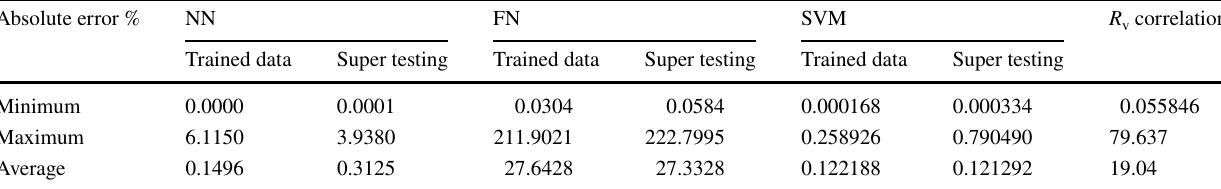
Table 4 Statistical comparison of all models and correlations